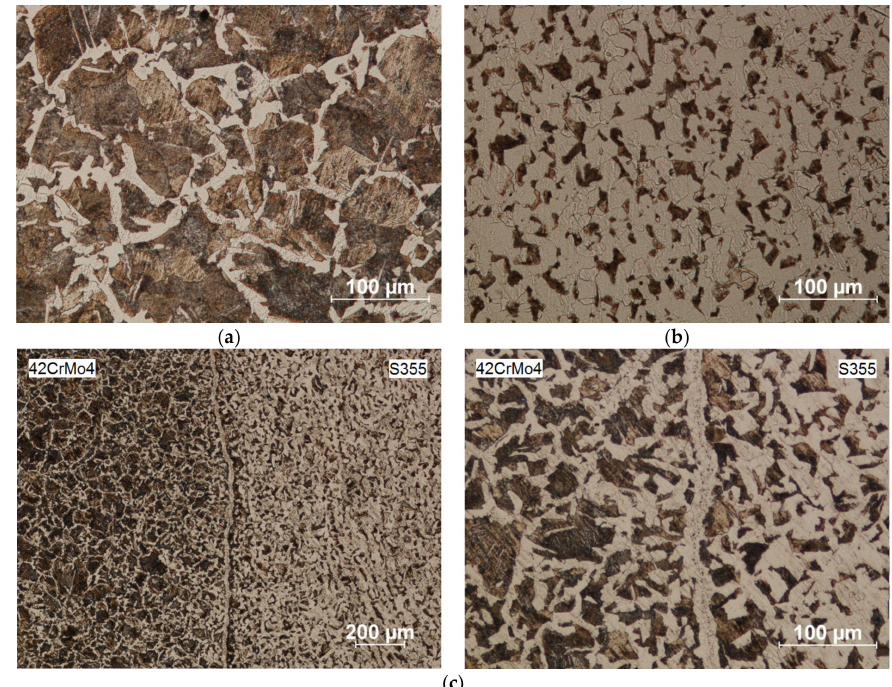
Figure 10. Microstructure of rolled bimetallic rods ( a ) S355 steel outer layer and a 42CrMo4 Scheme 42. CrMo4 steel; ( b ) microstructure outer layer—S355 steel; ( c ) microstructure of the welding